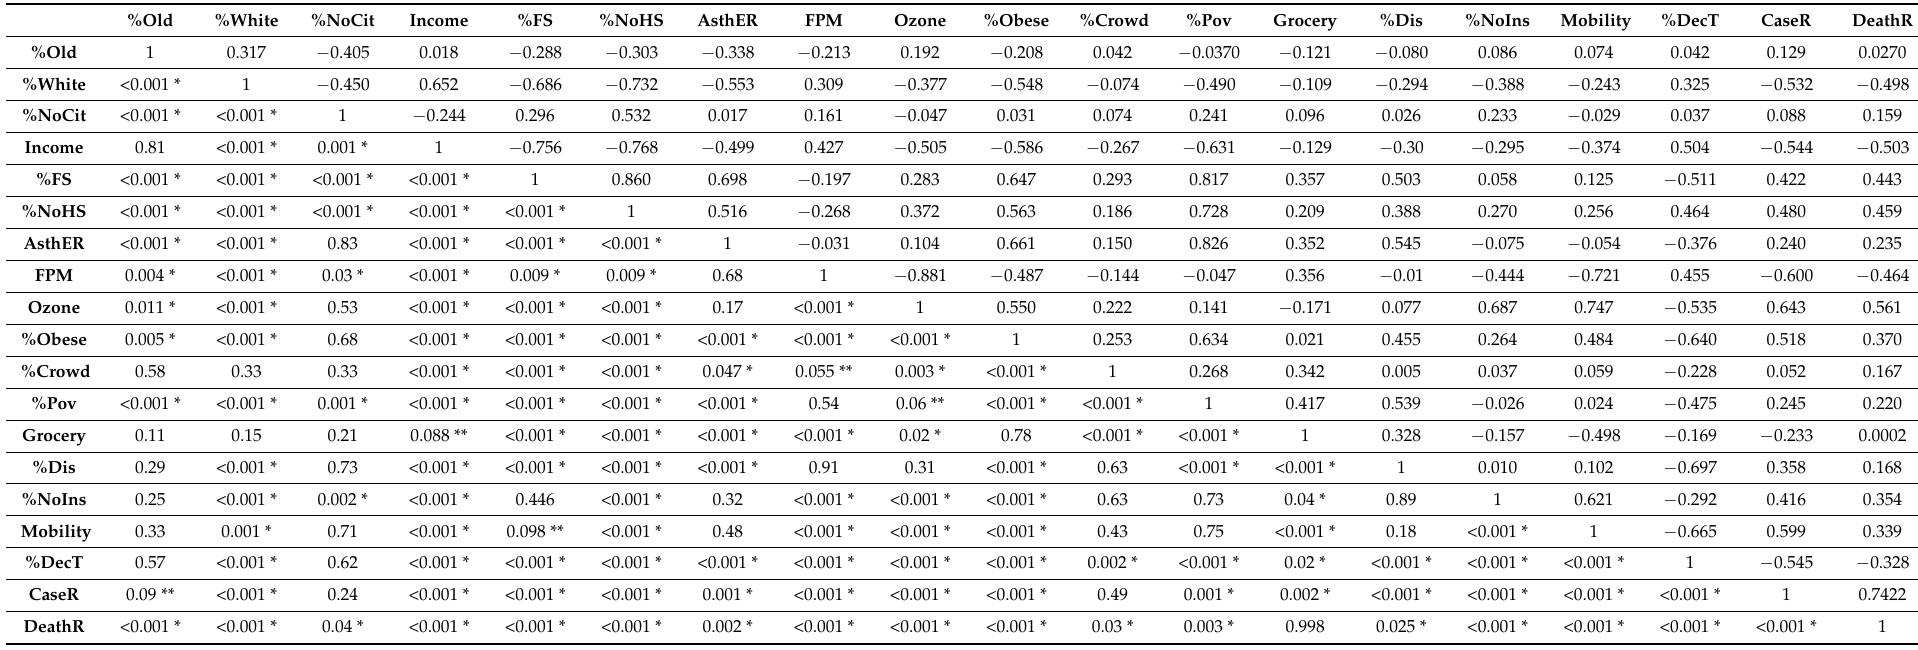
Table 4. Correlation matrix of all explanatory variables and response variables, containing correlation values in the upper triangle and p -values in the lower